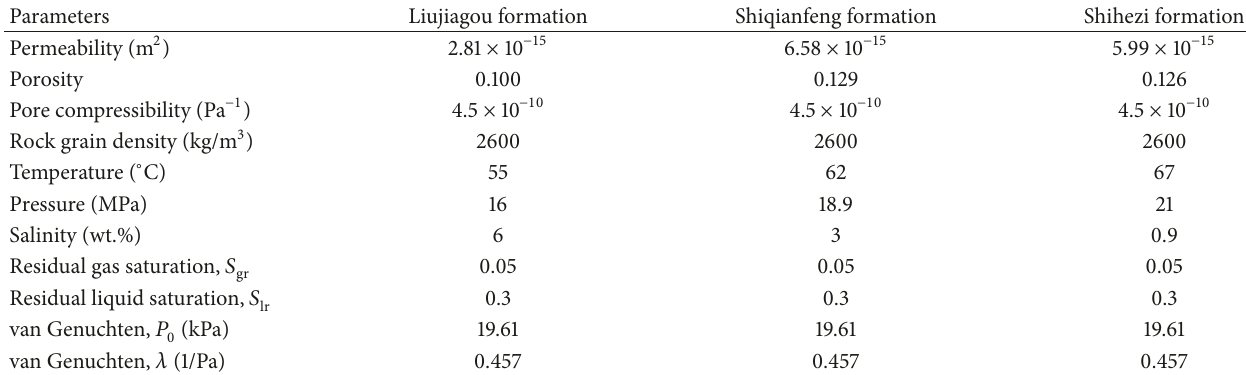
Table 3: Hydrogeological parameters of the three formations used in this